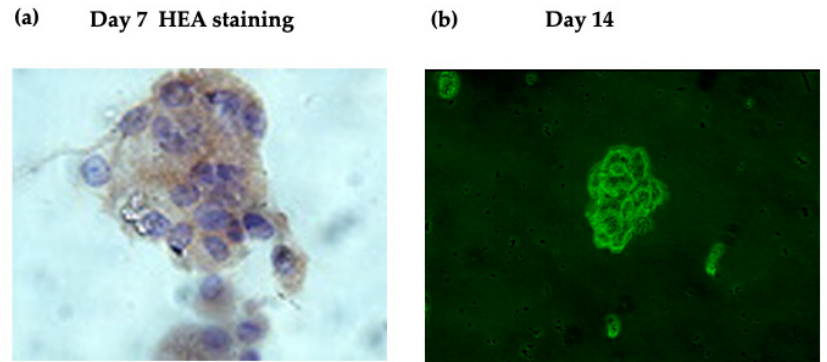
Figure 1. Representative images of the short-term CTC cell culture. ( a ) Cytospin image. Positive staining for Human Epithelial Antigen (HEA) was observed in cell clusters on day 7. ( b ) Phase contrast image of cell clusters on day 14 using a green filter [7].